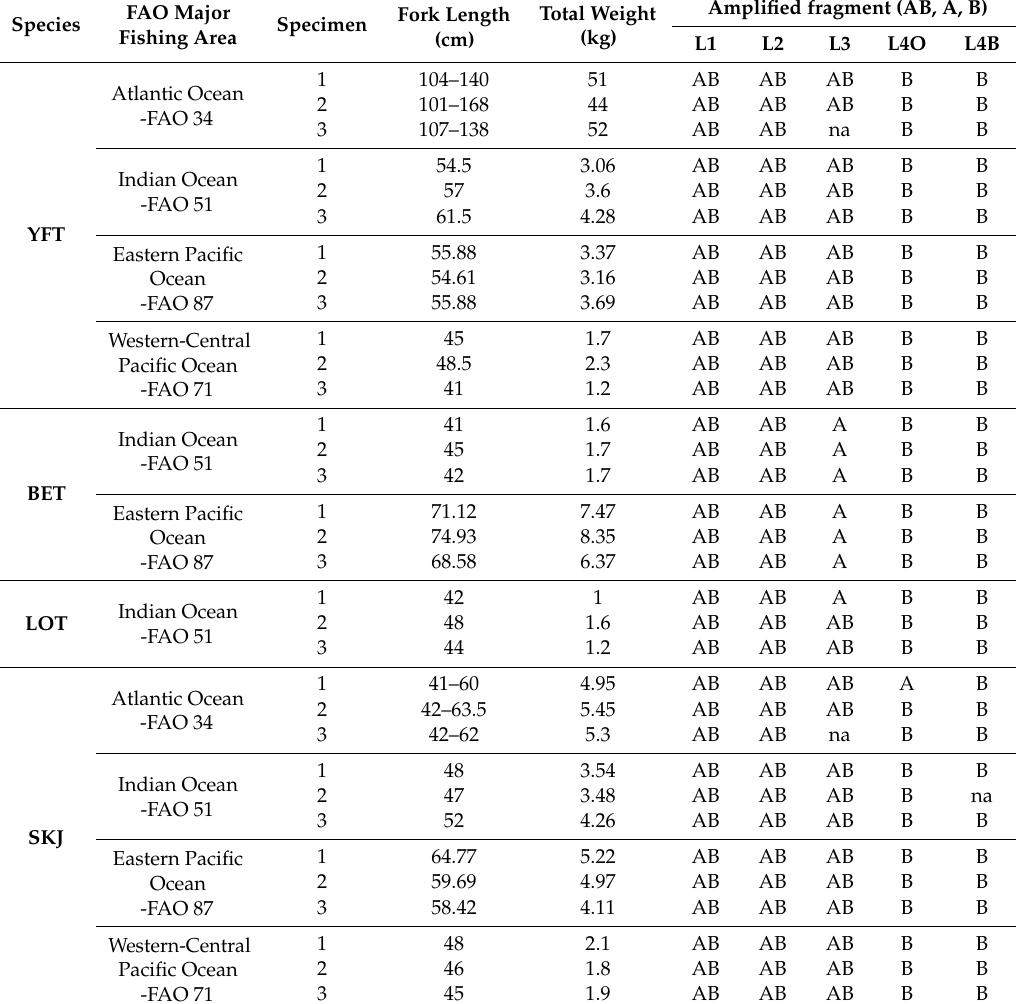
Table 1. Sampling and sequencing information for each specimen of the four species studied herein (Yellowfin tuna: YFT; Bigeye tuna: BET; Longtail tuna; LOT, Skipjack tuna: SKJ). The four processing levels: L1-L4. Amplified fragment of the mitochondrial gene Cyt b that were sequenced: AB (236 bp), A (117 bp), B (109 bp). Amplification failures: “na“. FAO Major Fishing Areas are detailed online: http: // www.fao.org / fishery / area / search /